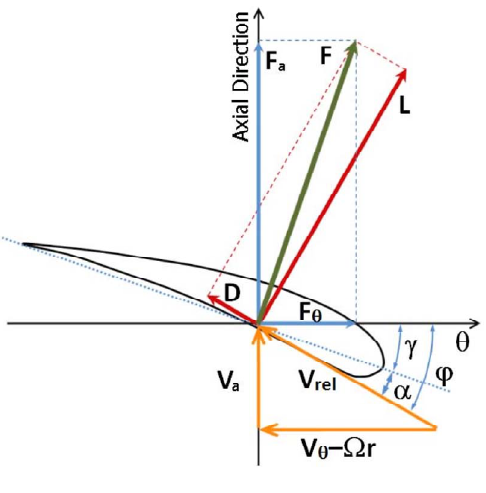
Figure 1. A cross-sectional aerofoil